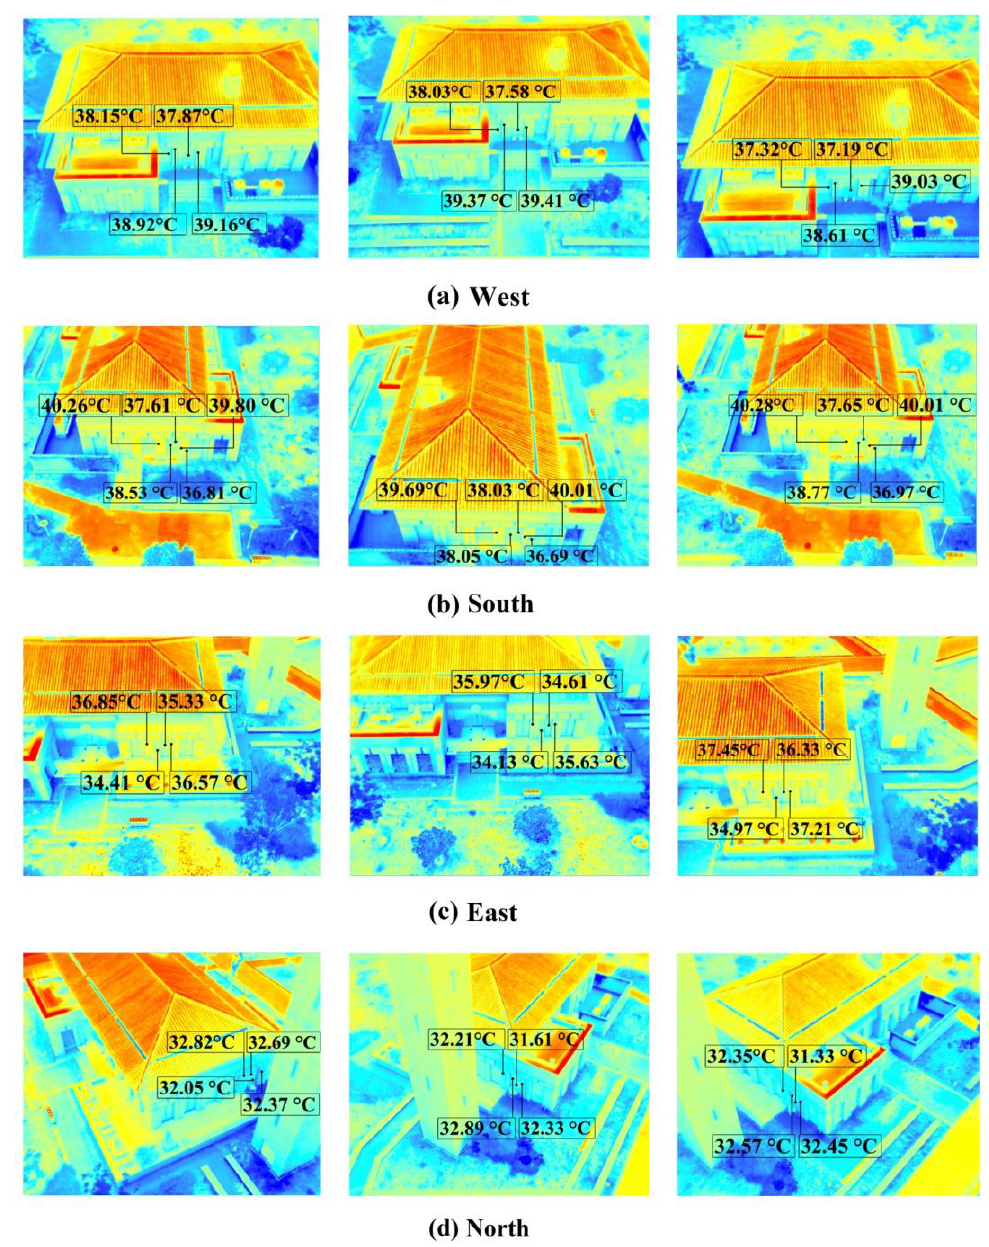
Figure 16. TIR temperature of the wall Figure 16. T IR temperature of the wall surface.